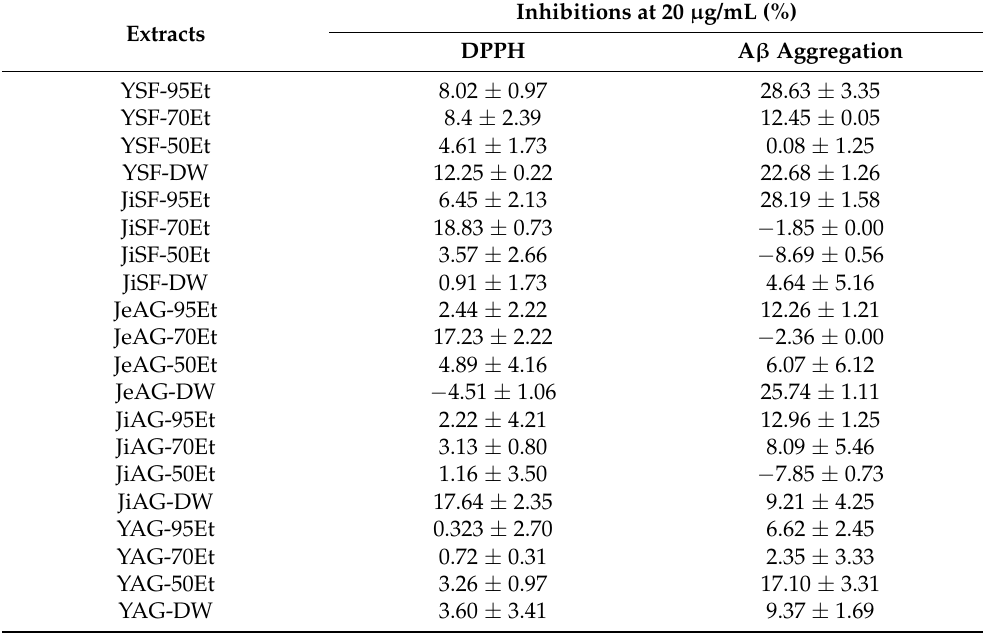
Table 2. Inhibitions of the extracts for DPPH radical scavenging activity and Aβ aggregation .